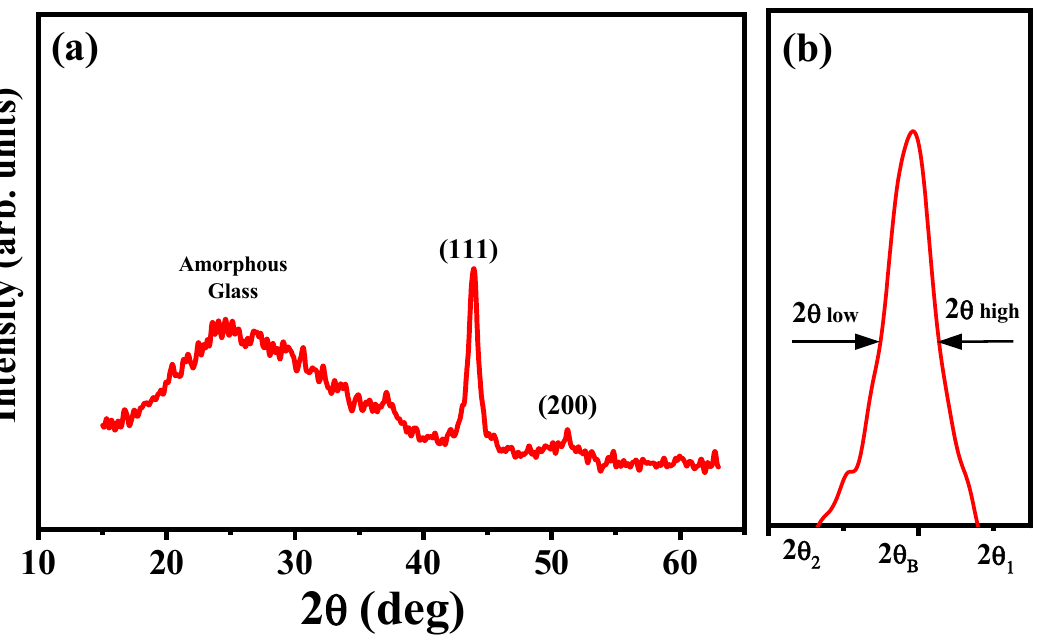
Figure 9. ( a ) X-ray diffraction analysis of synthesized nanofilms, ( b ) FWHM of the Cu peak.